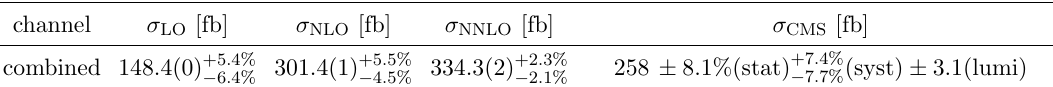
Table 4 . Fiducial cross sections for CMS 13 TeV. The available CMS data from ref. [8] are